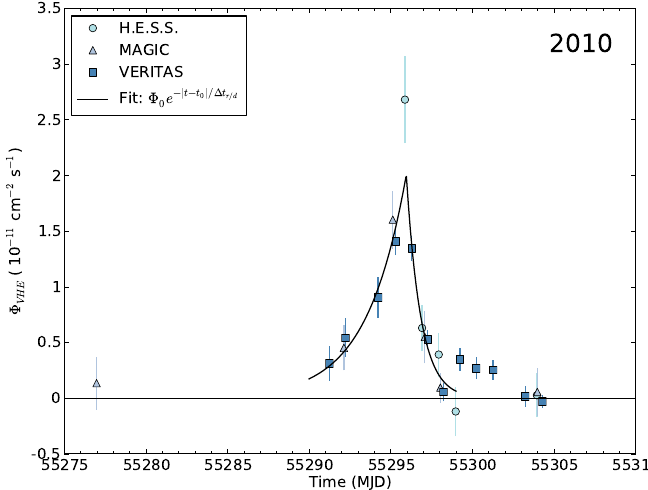
Figure 1. The very high energy (VHE) flare of the radio galaxy M87 in April 2010 as observed by H.E.S.S., MAGIC and VERITAS. Significant day-scale activity is evident. Since the jet in M87 is believed to be misaligned (suggestive of modest Doppler beaming only) and its black hole light-crossing scale large ( r s / c > ∼ 0.5 days), this VHE activity is extremely fast. The curve represents a fit by an exponential function, indicating doubling times of ∼ 1.7 days and ∼ 0.6 days during rise and decay, respectively. From [11].